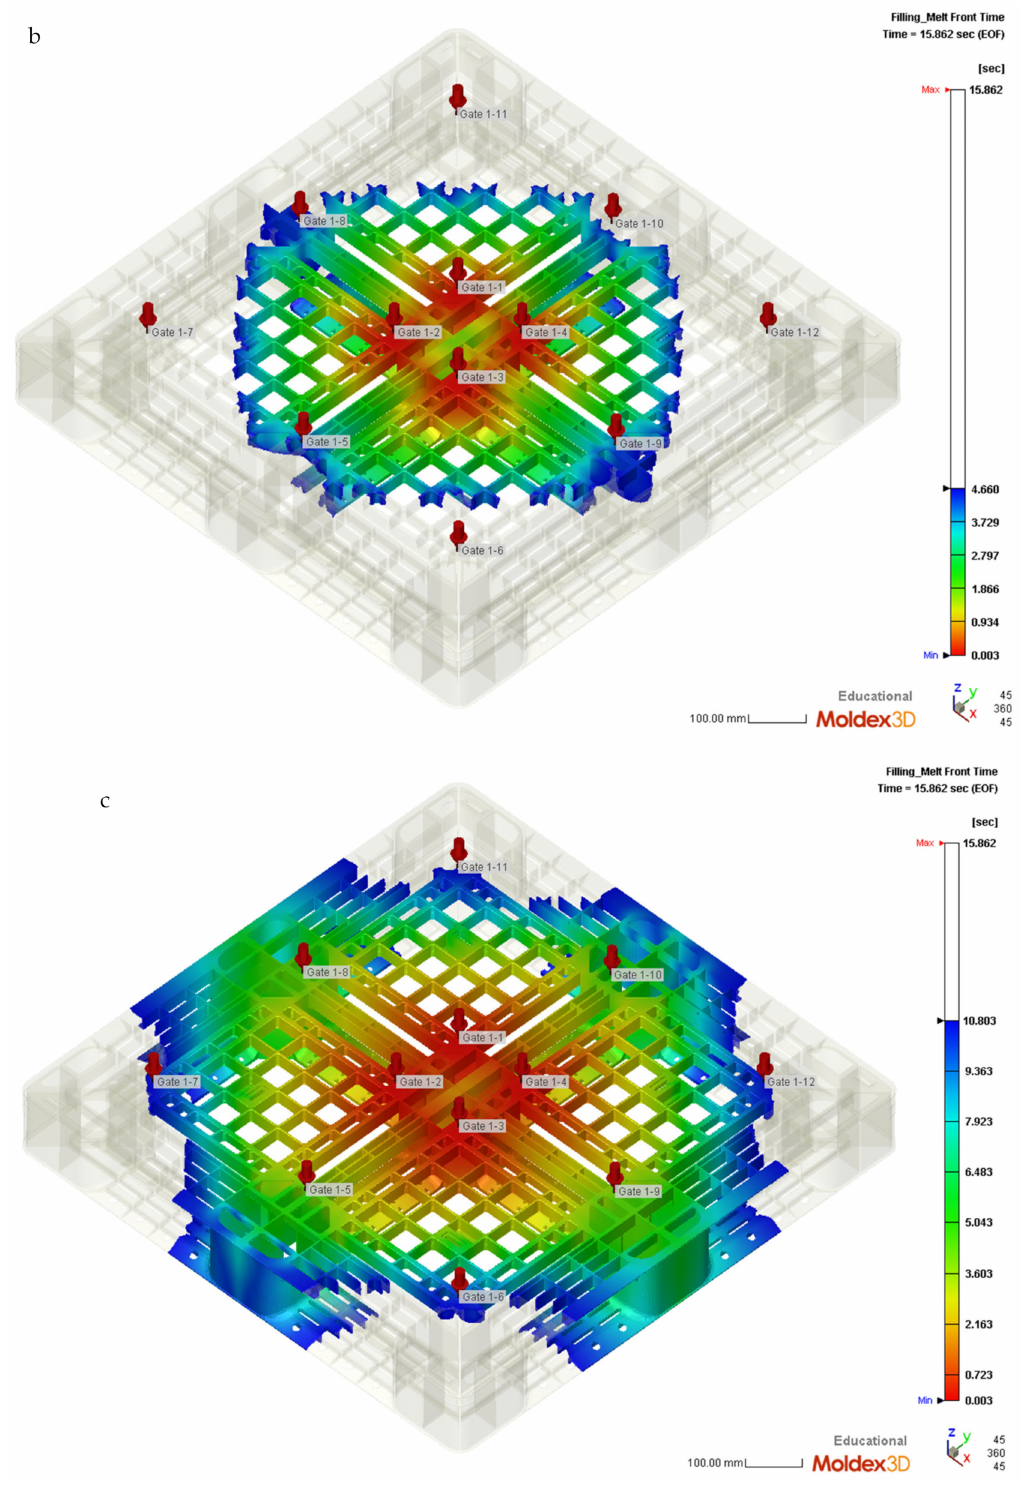
Figure 10. ( a ) Flow front spreading to hit gates 5 and 9 at 4.35 s; ( b ) Flow front spreading to hit gate 8 at 4.67 s; ( c ) Flow front spreading to hit gates 6, 7, 11, and 129 at 10.8